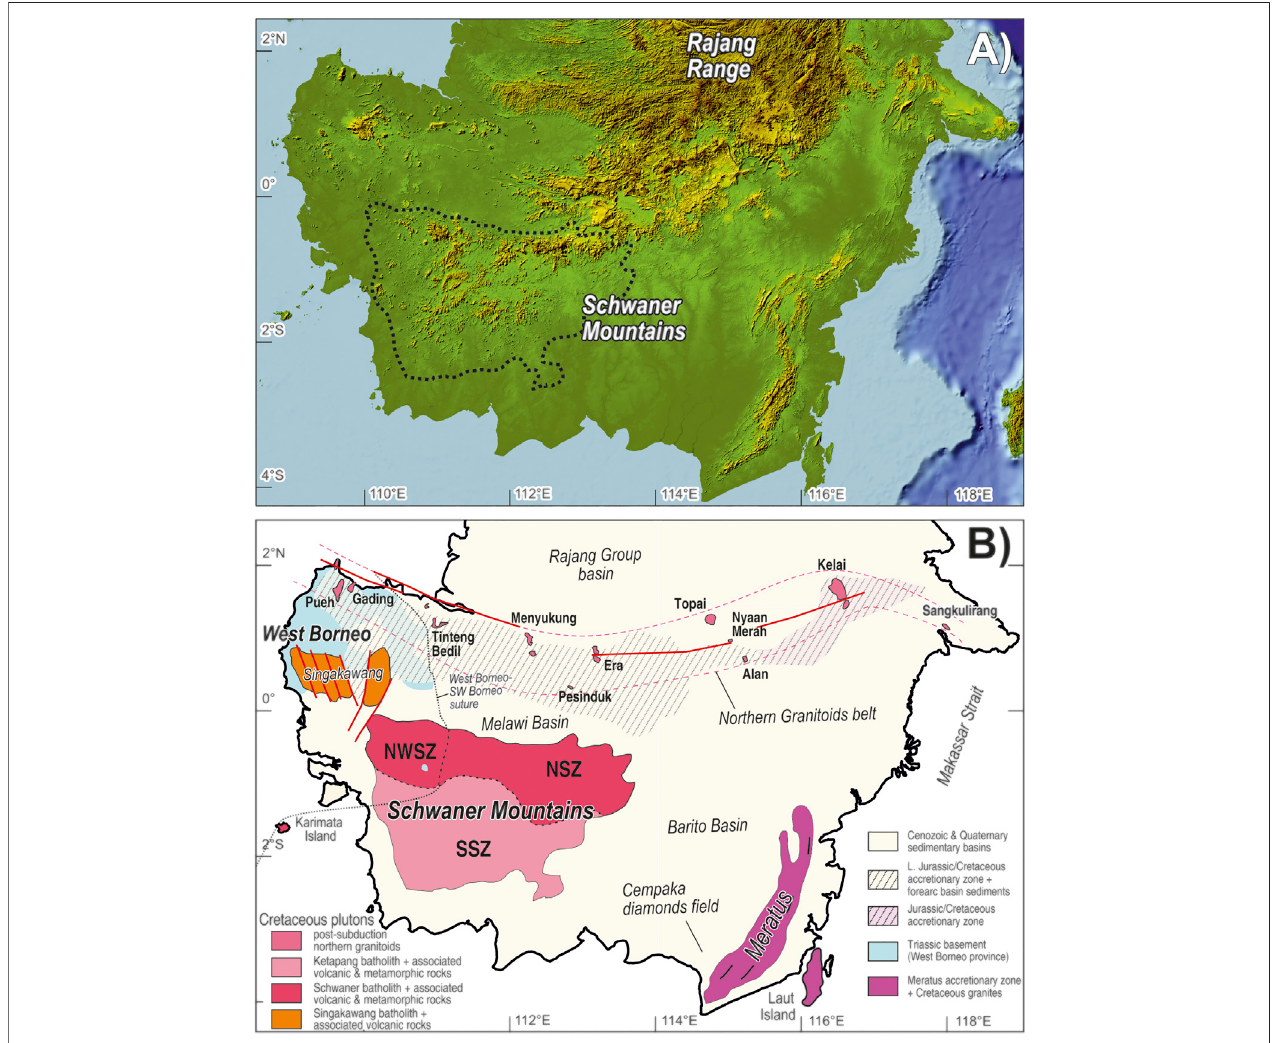
FIGURE2|(A) SRTMimageshowinglocationoftheSchwanerMountains. (B) CretaceousgranitoidsandbasementmapofsouthernBorneo.NWSchwanerZone (NWSZ) is part of the West Borneo province and has a Triassic and Jurassic basement intruded by Cretaceous granites. The North Schwaner Zone (NSZ) is dominated by the subduction-related Sepauk Tonalite. The South Schwaner Zone (SSZ) includes the Jurassic within-plate Belaban Granite and the post-subduction Cretaceous SukadanaGranite.TheUpperCretaceousNorthernGranitoidsbeltfollowstheLuparLinefaultsystem.SouthernboundaryofWestBorneoeitherisrepresentedby the NWSZ or by an unidenti fi ed ENE-WSW striking line crossing the western part of the SSZ (modi fi ed from Hennig et al., 2017).